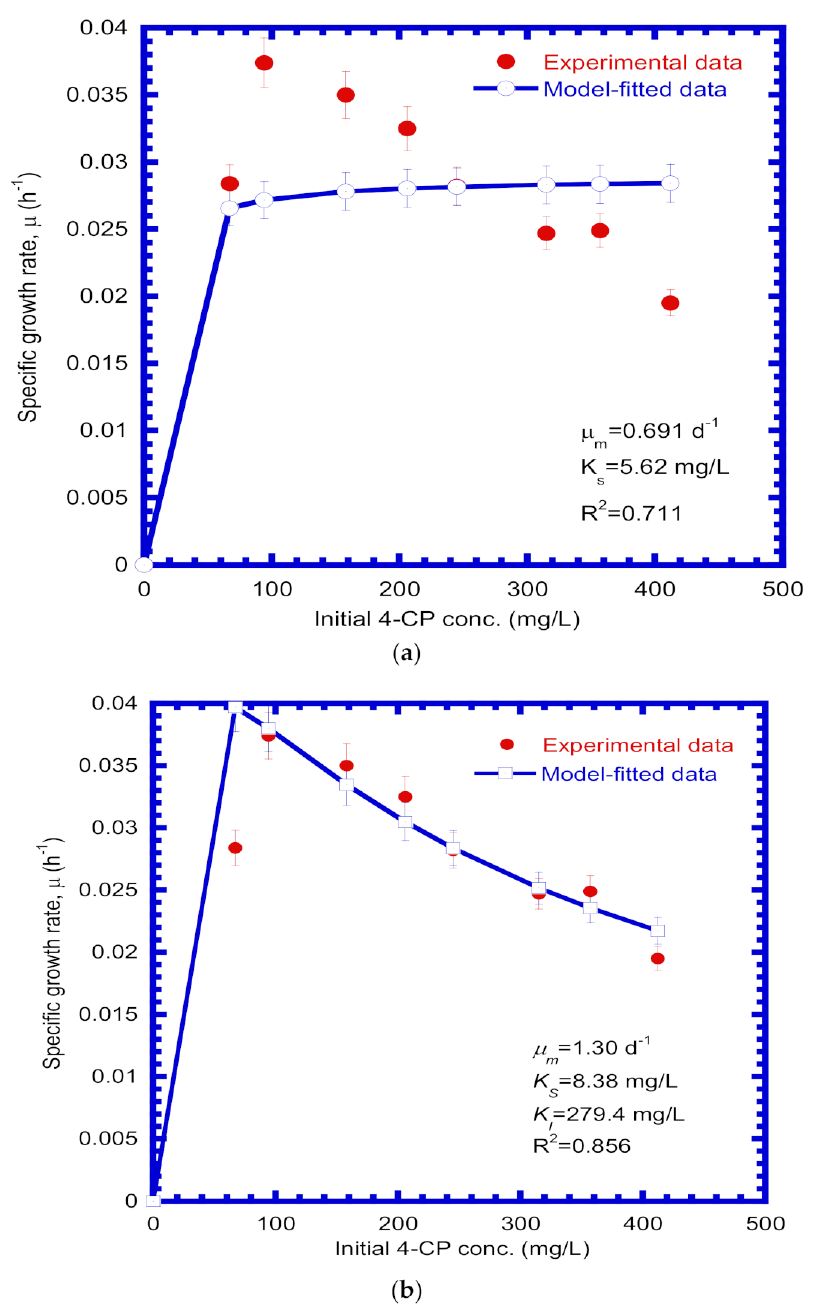
Figure 3. Comparison of experimental and model-fitted data to determine kinetic parameters: ( a ) Monod kinetics and ( b ) Haldane kinetics. The experimental data presented are means of three